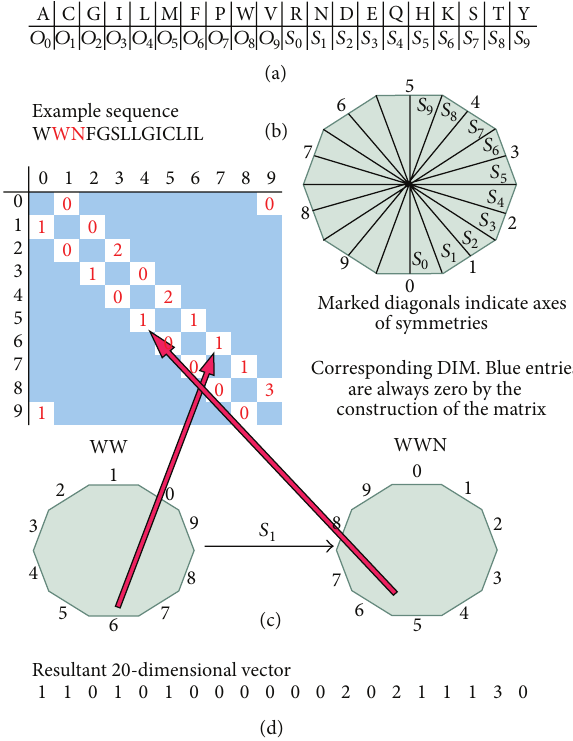
Figure 2: Decagonal isometries matrix D 10 . (a) and (b) show correspondance between group elements and amino acids and indicate the initial step of coding. Decagons below show the explicit transformation for thegiven step (WW → WWN) and theresultant DIM (c). The 20-dimensional vector constructed from the matrix is usedasadescriptortonumericallycharacterizetheproteinsequence